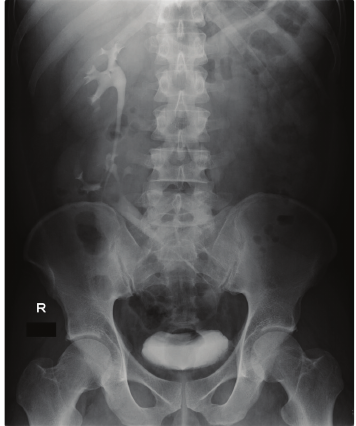
Figure 2: One month after the extracorporeal shock wave lithot- ripsy, intravenous urography confirms the absence of any residual stone. The ureter of the ectopic kidney is seen to cross the midline and enter into the urinary bladder at the normal